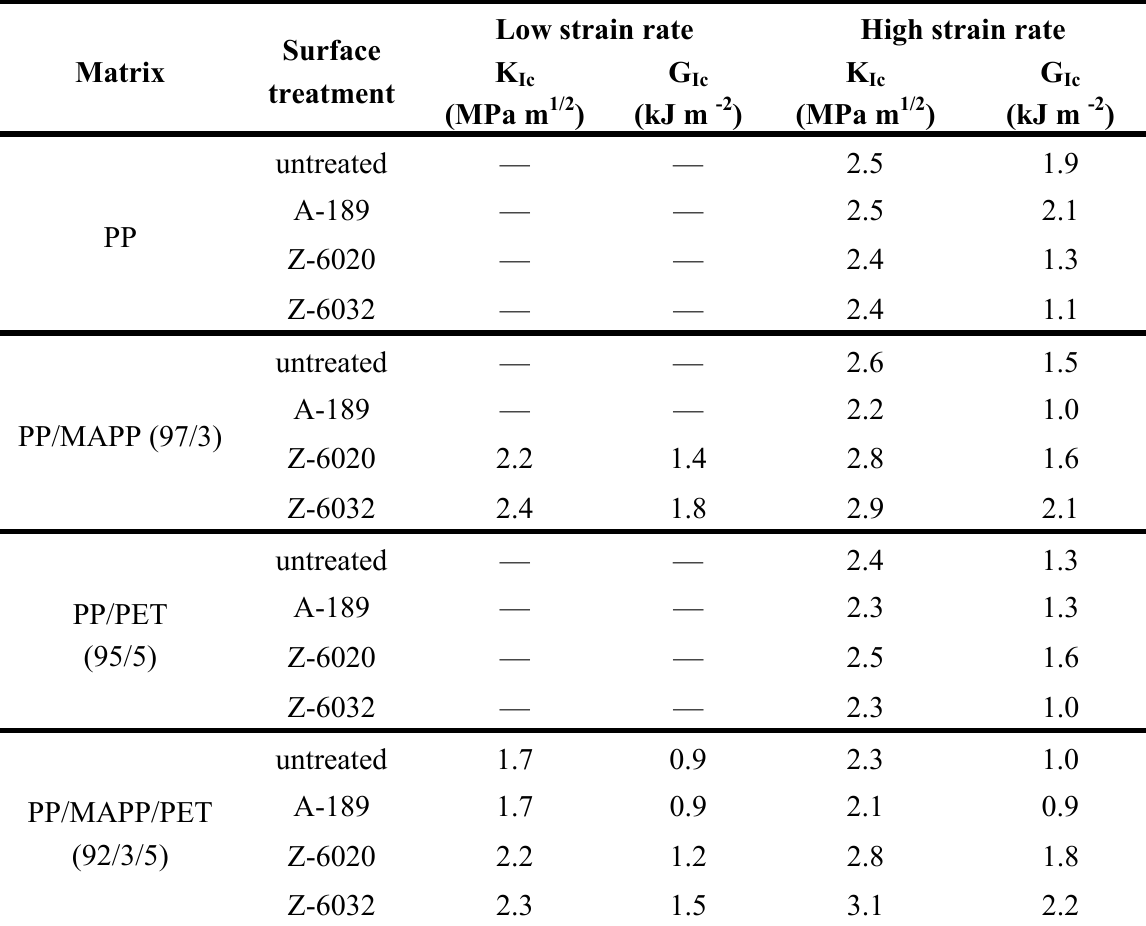
Table 3. LEFM analysis of PP-glass bead composites with 26 vol.% of particles (data extracted from